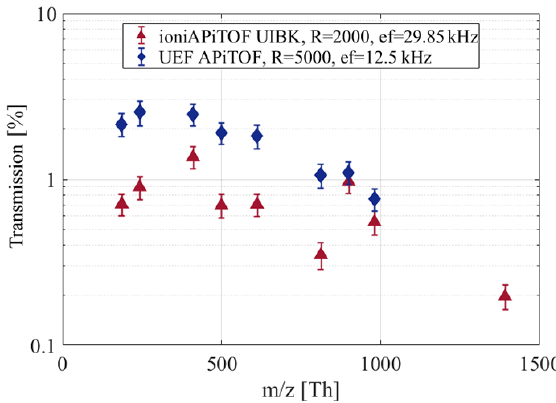
Figure 8. Comparison of the ioniAPi-TOF and the UEF APi-TOF regarding the transmission efficiency. The UEF API-TOF is set to high-mass range settings ( m/z 100–2000Th). The extraction fre- quencies (ef) vary with the length of the TOF mass